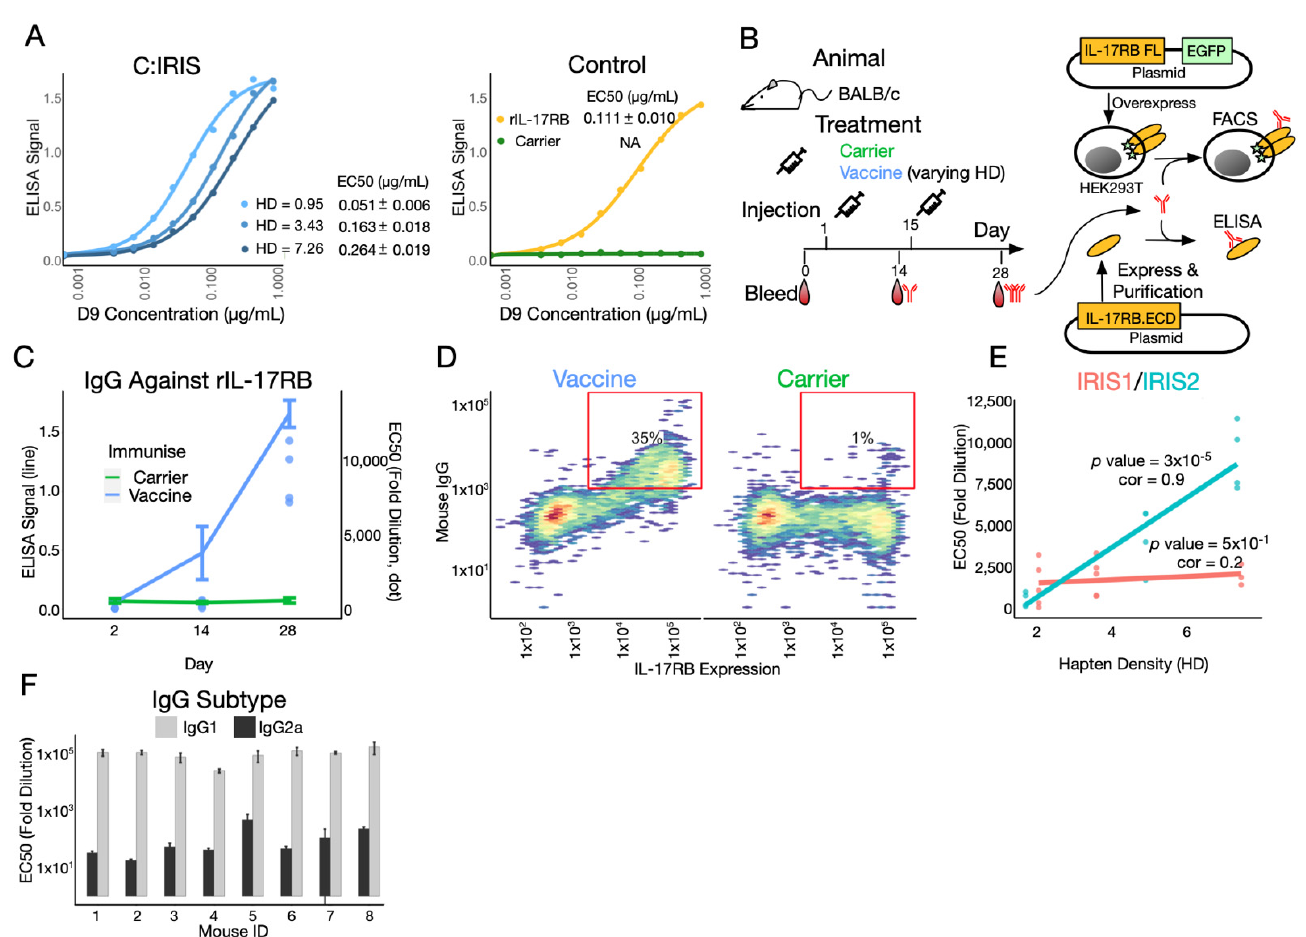
Figure 3. C:IRIS presents natural epitope and induces potent and specific immune response. ( A ) Binding pattern of serial diluted D9 antibody to C:IRIS (Conjugate) and control groups (Control) measured by ELISA. EC50 estimation of D9 antibody binding to different coated antigens is shown in table to the right ( B ) Schematic of the study. C:IRIS (Vaccine) or CRM197 (Carrier) was subcutaneously given to mice at day 1 and 15. Antiserum was collected and tested by ELISA and FACS using purified recombinant IL-17RB ectodomain (IL-17RB.ECD) and IL-17RB overexpressing cells, respectively. ( C ) Day 0, 14 and 28 antiserum from Vaccine- or Carrier-immunized mice were tested for their IgG response against recombinant IL-17RB ectodomain coated ELISA plate. ELISA signal (OD450) from antiserum diluted 810 times is shown as lines and error bars, whereas half maximal effective concentrations (EC50) are shown in dots. ( D ) Using flow cytometry, the IgG response of mice immunized with Carrier or Vaccine is measured by their binding capacity to IL-17RB overexpressing cells from panel B. ( E ) EC50 (fold dilution) of antiserum from mice immunized with C:IRIS prepared with IRIS1 or IRIS2 at different hapten densities (HD). Linear regression is fitted in each panel along with statistical analysis. ( F ) Comparison of EC50 on IgG subtypes (IgG1 and IgG2a) in each mouse among higher responders.